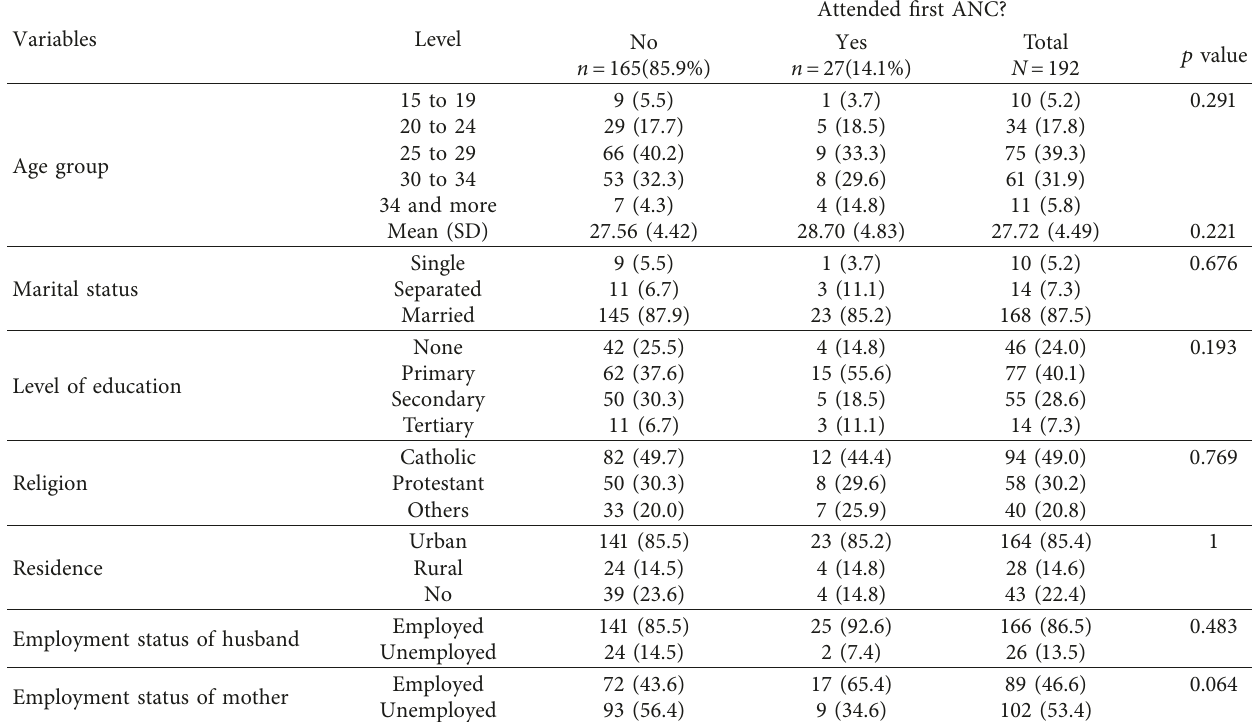
Table 2: Bivariate analysis of socio-demographic factors and timely attendance of the first ANC.